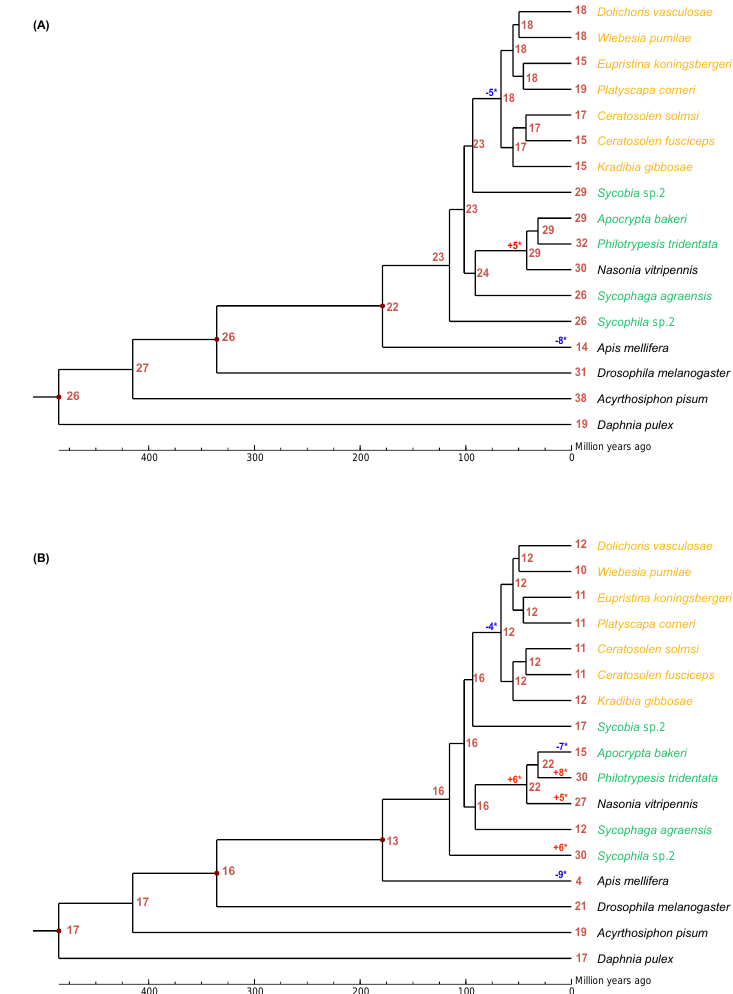
Figure 1. The expansion and contraction of lipase gene family. Numbers on each node are the estimated ancestral copy numbers. The names of pollinator fig wasps are indicated with orange and that of non-pollinating fig wasps are indicated with green. ( A ) neutral lipase, ( B ) acid lipase. The significant expansion and contraction of lipase gene families were indicated with asterisk (*).